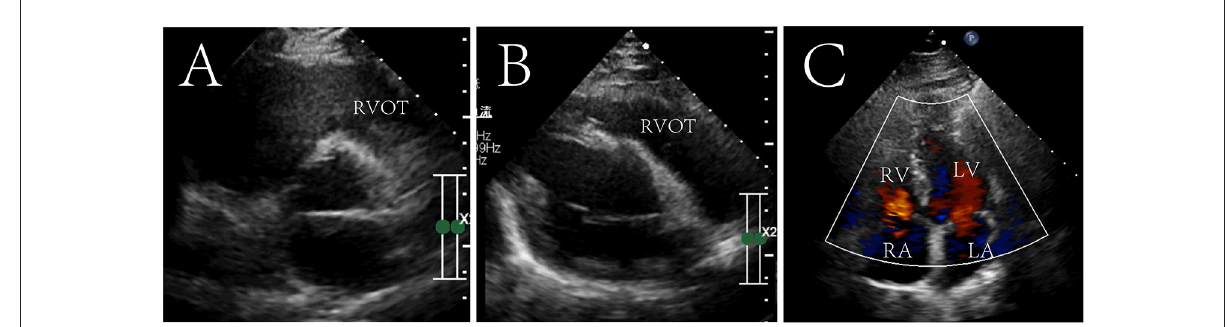
FIGURE3 Seven-year postoperative echocardiography in transthoracic aortic short-axis views (A) , right ventricular outflow tract view (B) and four chamber cross section view (C) . The tumor did not recur and the right ventricular outflow tract was not obstructed. Right ventricular outflow tract, RVOT; RV, right ventricle; LV, left ventricle; RA, right atrium; LA, left